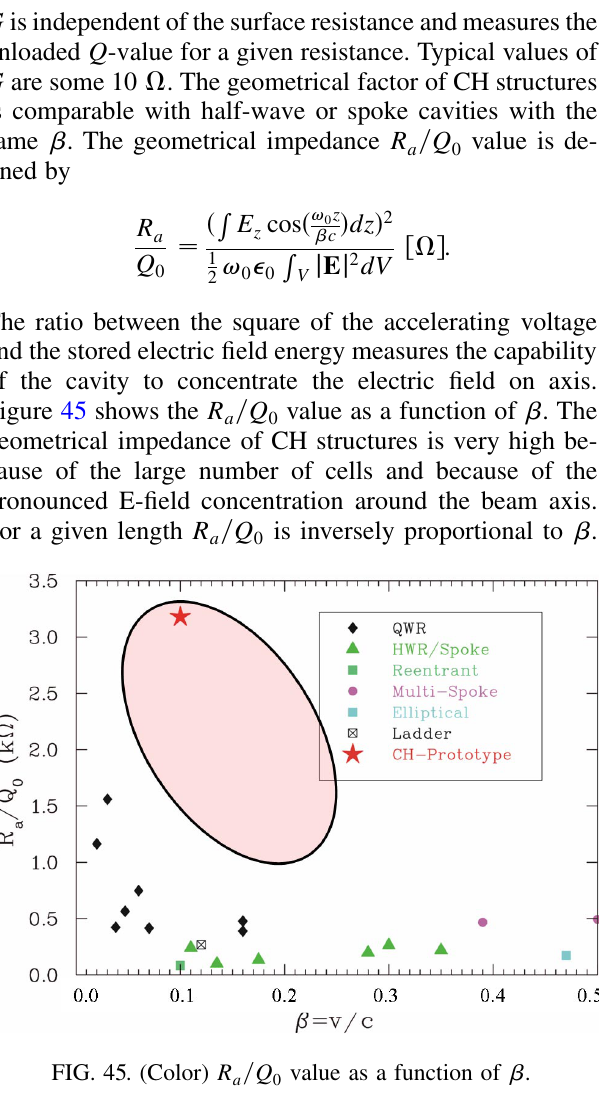
FIG. 44. (Color) Geometrical factor G (cid:1) R (cid:1) . See the legend in Fig. 43.